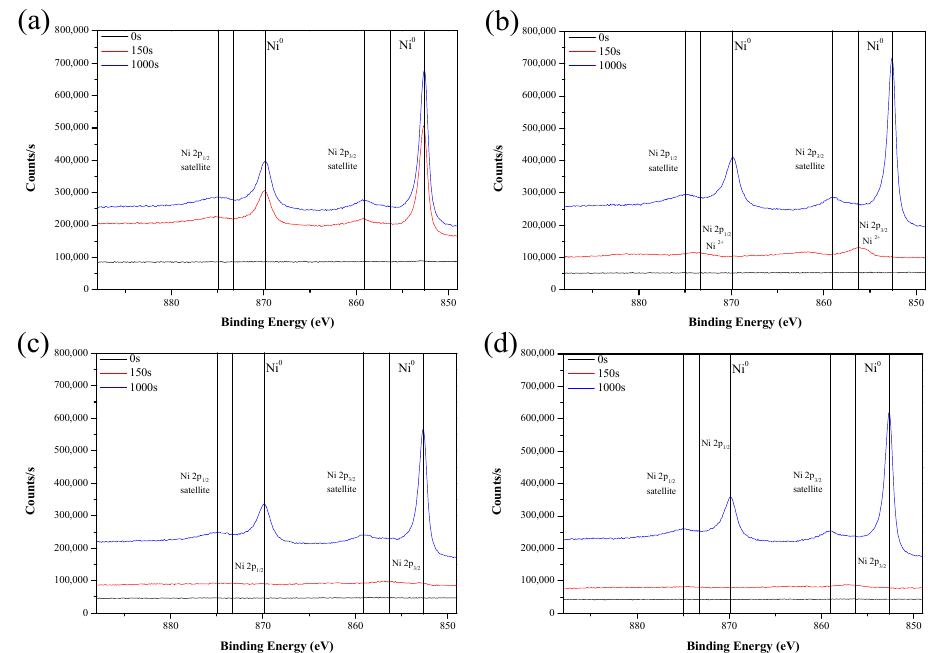
Figure 14. XPS spectra: Ni 2p binding energies determined from Ni 2p scans of ( a ) Zn–Ni alloy, ( b ) NaF 0% 60 s chromium conversion treatment, ( c ) NaF 50% 60 s chromium conversion treatment, and ( d ) NaF 100% 60 s chromium conversion treatment.